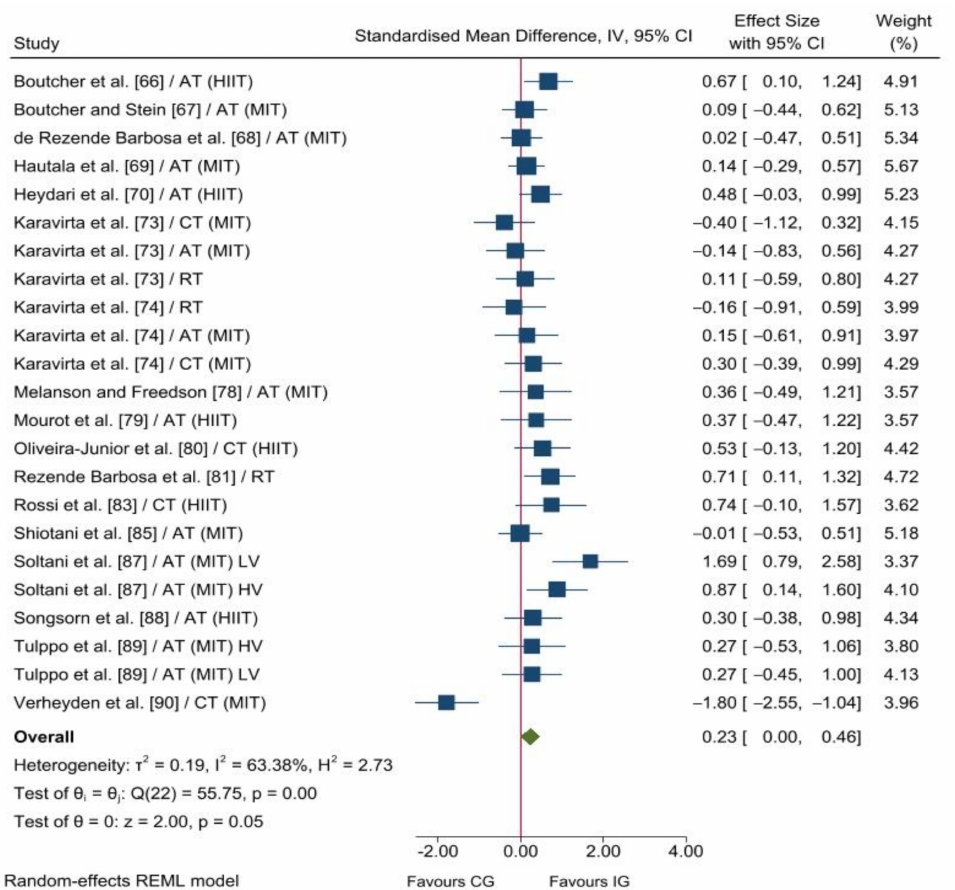
Figure 3. Forest plot of standardised mean difference between the intervention and control groups for HF. AT, aerobic training; CG, control group; CI, confidence interval; CT, combined aerobic and training; HIIT, high-intensity interval training; HV, high volume; IG, intervention group; IV, inverse variance; LV, low volume; MIT, moderate intensity training; RT, resistance training